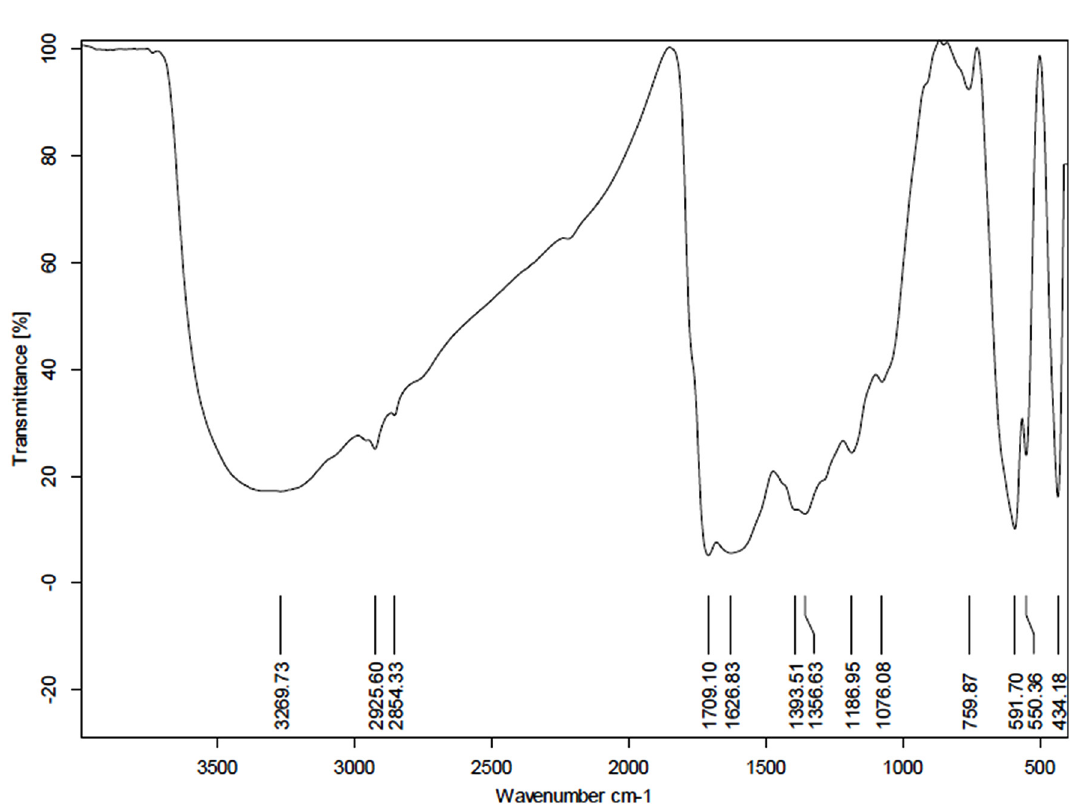
calcinated at 500°C. 3